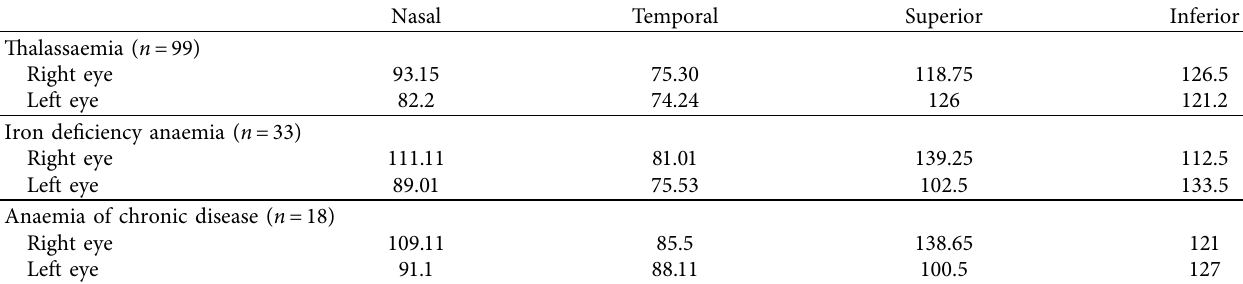
Table 3: Distribution of mean RNFL (in micrometres) in nasal, temporal, superior, and inferior quadrants in the study population.